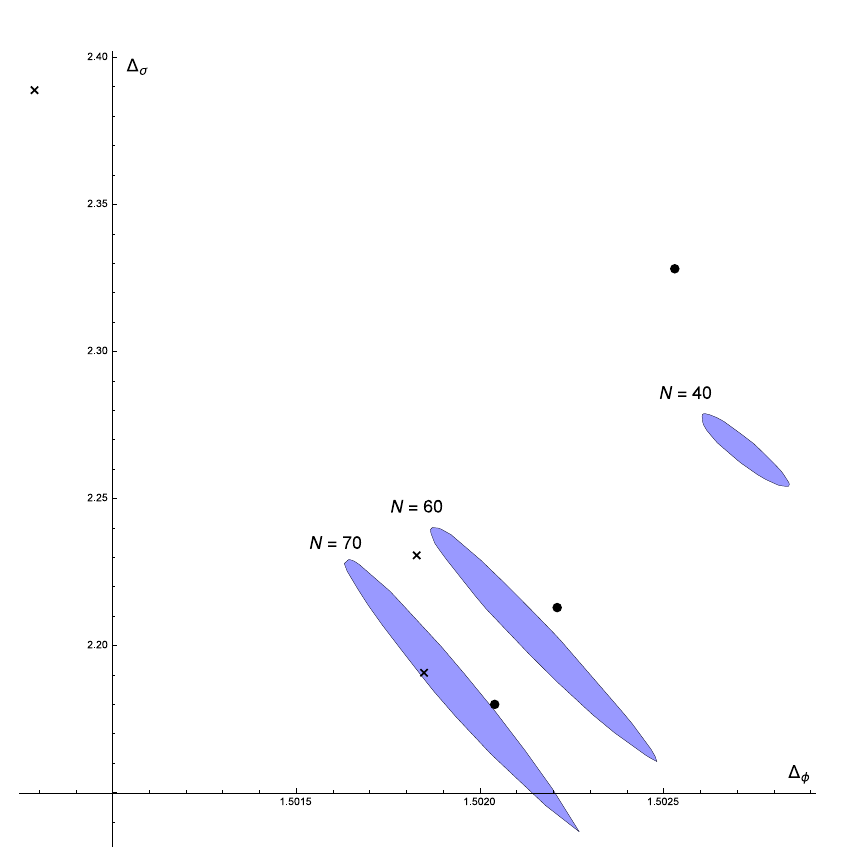
Figure 3 . From top to bottom, the islands represent the allowed regions of ((cid:1) (cid:30) ; (cid:1) (cid:27) ) in the 5 D O ( N ) N = 40 ; 60 ; 70 vector models. The results are obtained from conformal bootstrap with (cid:3) = 19 and spins S (cid:3)=19 . The black dots and crosses denote predictions from (cid:15) expansion and large N expansions, respectively. The dimension gaps used in conformal bootstrap program are: ((cid:1) (cid:3) ; (cid:1) (cid:3) ) = (3 : 4 ; 4 : 1) for N = 40, ((cid:1) (cid:3) ; (cid:1) (cid:3) ) = (3 : 5 ; 4 : 3) for N = 60 ; 70. The perturbative S; 0 V; 0 S; 0 V; 0 methods, especially the large N expansion get abnormal and stay away from the region allowed by conformal bootstrap at N =